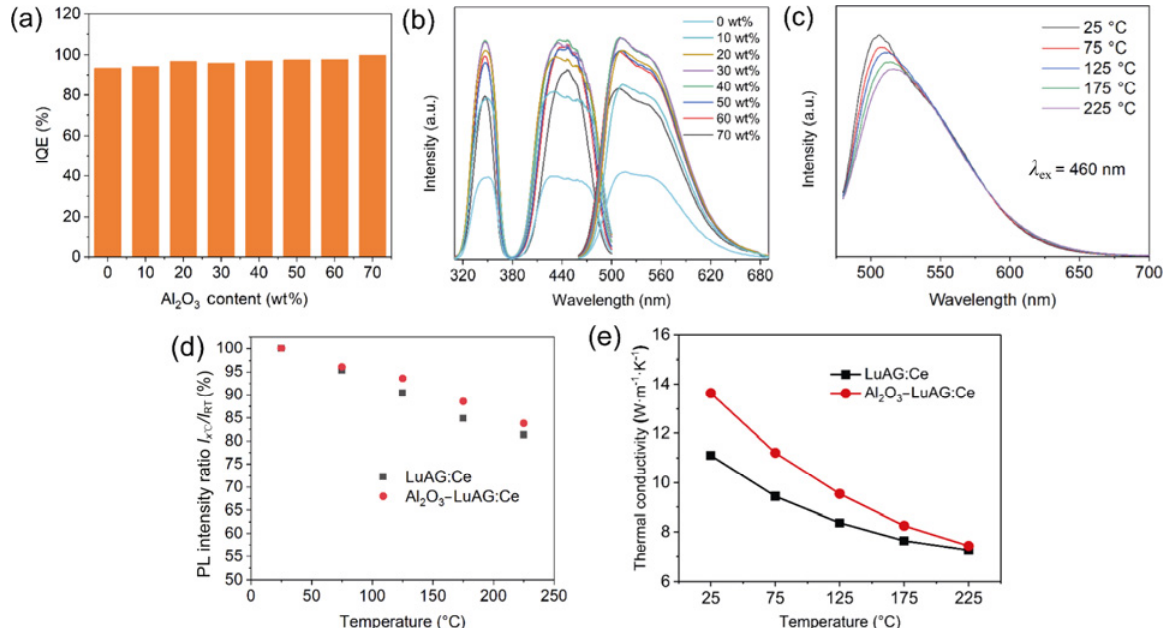
Fig. 4 (a) Internal quantum efficiency and (b) PL/PLE spectra of LACCs with different Al 2 O 3 contents. (c) Temperature- dependent PL spectra of 50 wt% LACCs. (d) Thermal stability and (e) thermal conductivity of LuAG:Ce and 50 wt% LACCs with increasing